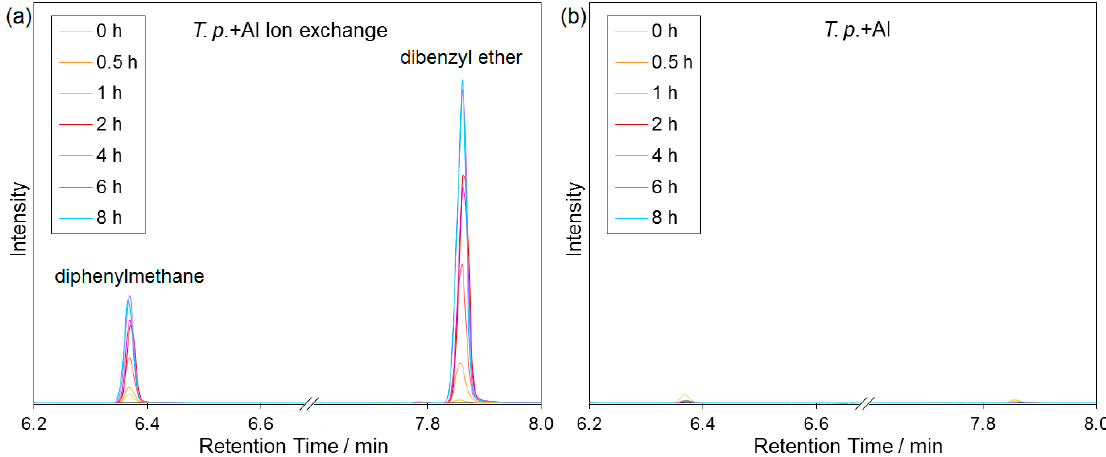
Figure 8. Chromatograms of the reaction mixture (section of the product peaks); ( a ) with Al enriched and ion exchanged biosilica ( T.p. + Al Ion exchange) and ( b ) with Al enriched biosilica without ion exchange ( T.p. + Al); chromatograms normalized to the same amount of internal standard; and, selected ion traces (6.2–6.87 min: m / z 167, 6.87–8.0 min: m / z 92).